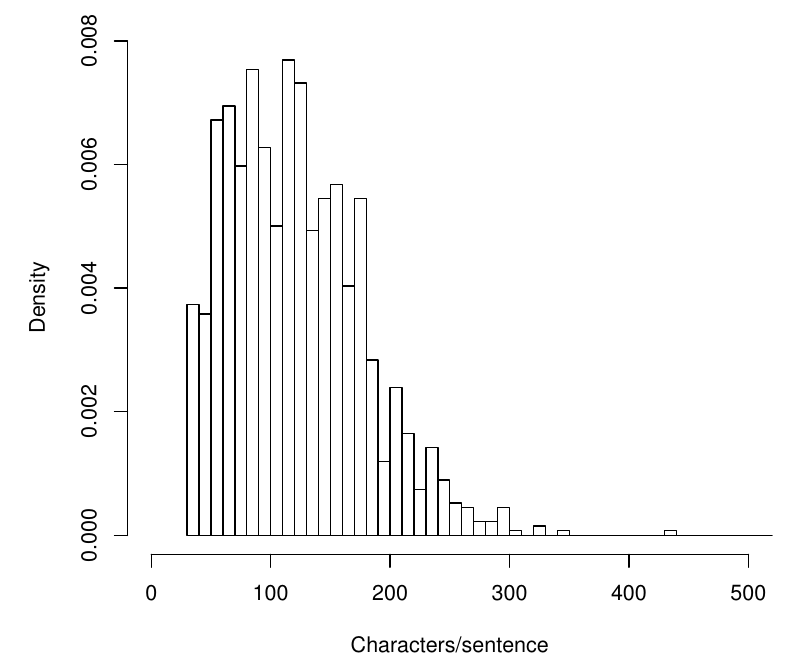
Figure 1. Length of a documentation sentence